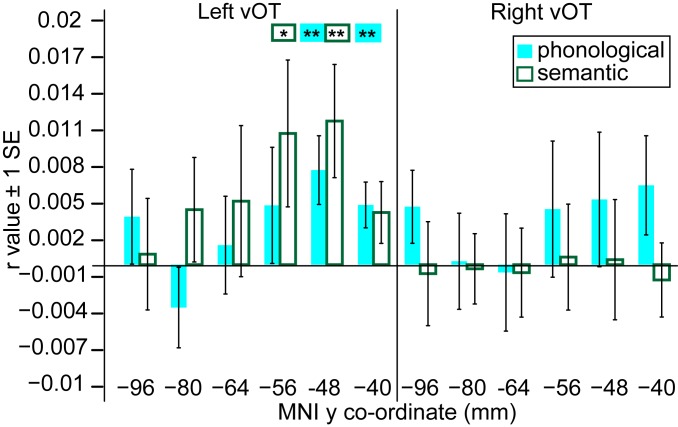
Correlations between the neural and phonological (cyan) and semantic (green) DSMs in left- and right-hemisphere ROIs, from posterior to anterior vOT along the x axis. Asterisks denote whether second-level one-sample t tests in each ROI indicated a significantly greater than zero correlation (one-tailed t test, **P < 0.01, *P < 0.05). SE bars are appropriate for these one-sample t tests.